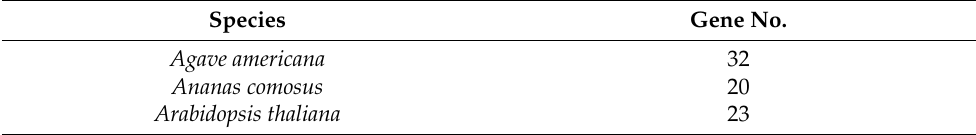
Table 1. Summary of the number of ARF genes in species that have been